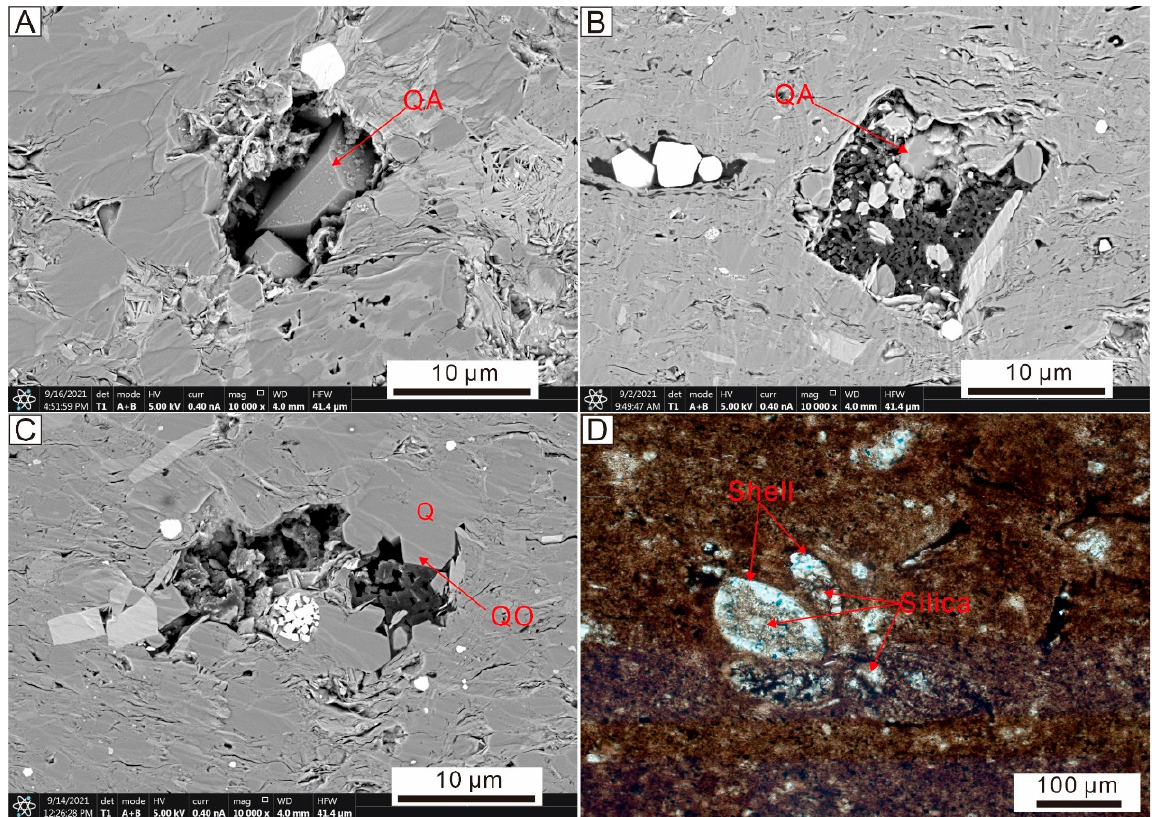
Figure 18. Authigenic quartz in FGSRs. (Abbreviations: QA = authigenic micro ‐ sized quartz; QO = quartz overgrowth; Q = quartz). ( A ) Authigenic micro ‐ sized quartz in pores, well X8HC, 2333.6 m; ( B ) authigenic micro ‐ sized quartz in pores, well X8HC, 2391.05 m; ( C ) quartz overgrowth, well X8HC, 2317.1 m; ( D ) silica filled in shells, well X3HC, 2445.2 m.